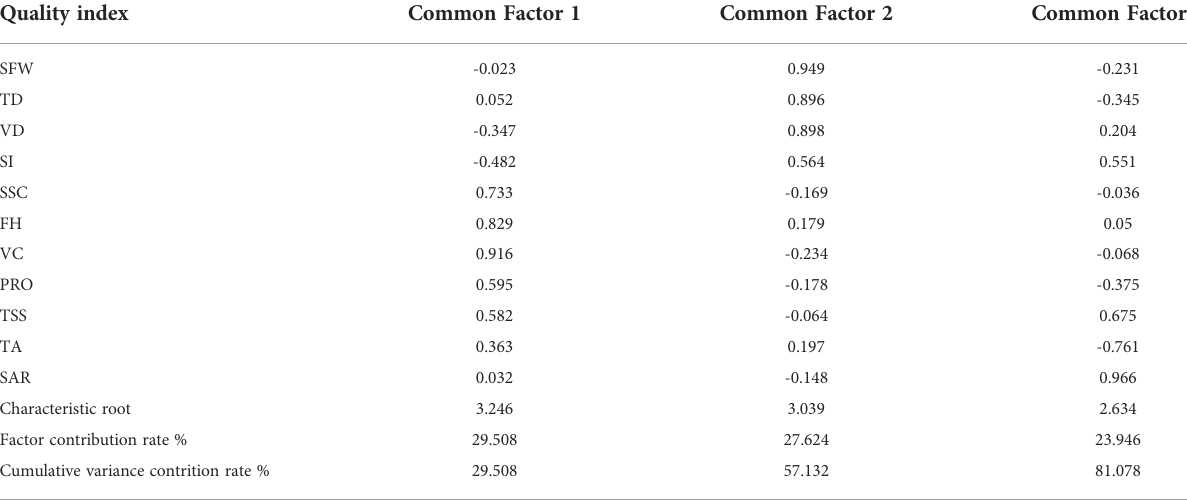
TABLE 5 Post-rotating principal component vector matrix and total variance